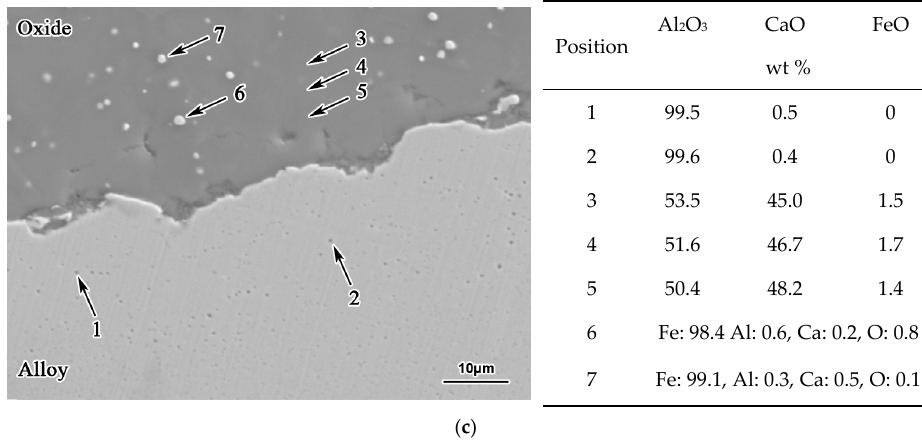
Figure 6. Morphology of interface between the alloy and oxide in the diffusion couple of G0, G1, and G2 after the heat treatment at 1473 K for 50 h: ( a ) G0-50; ( b ) G1-50; ( c ) G2-50.